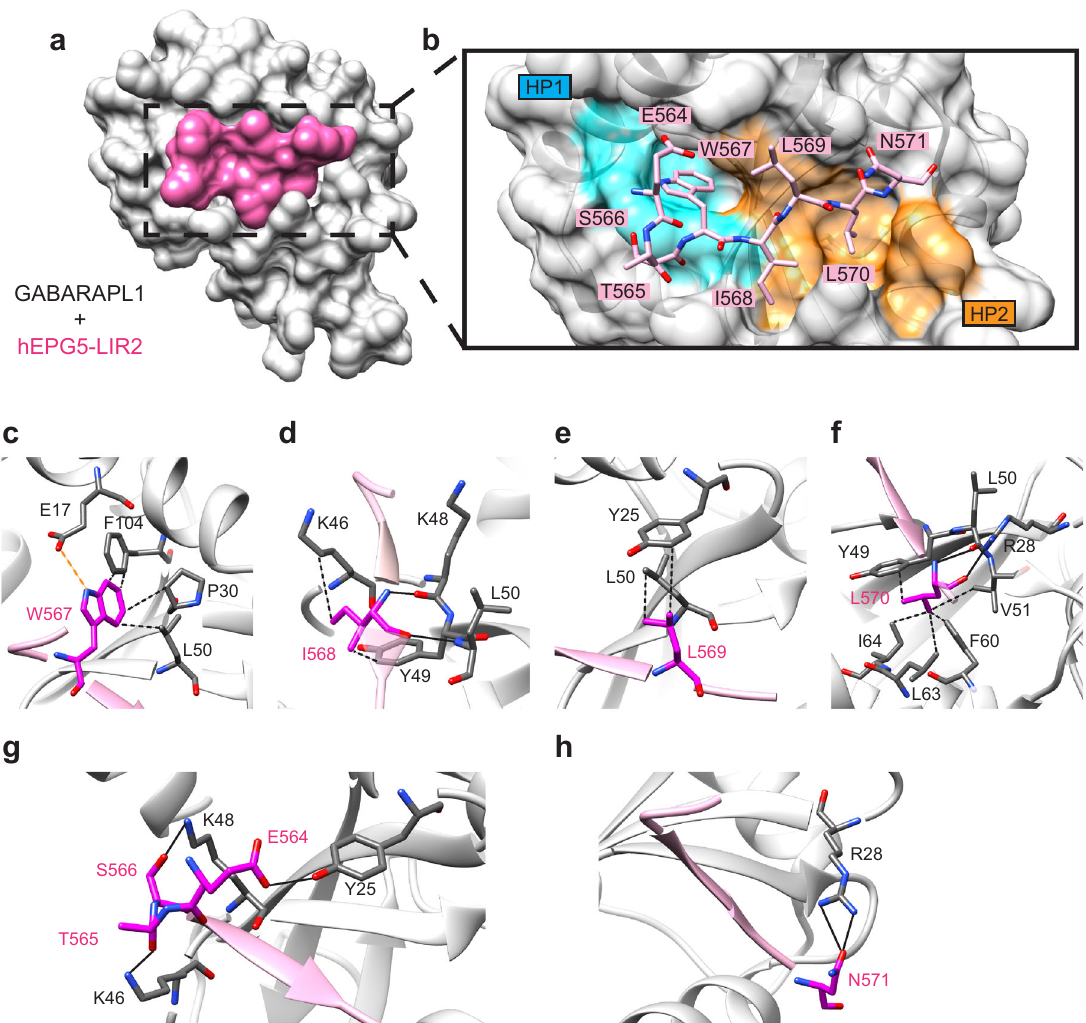
Fig. 4 Crystal structure of the LIR2 – GABARAPL1 complex. a Surface representation of complex between LIR2 peptide (magenta) and GABARAPL1 (gray) at 1.91 Å. b Close-up view of LIR2 peptide (sticks representation in pink) binding to canonical binding site on GABARAPL1 (ribbon and transparent surface representation in gray). Residues Trp567 and Leu570 of LIR2 inserted into hydrophobic pocket 1 (HP1 in cyan) and hydrophobic pocket 2 (HP2 in orange) through hydrophobic interaction, respectively. c – f Close-up view of the interactions between each of the LIR2 motif residues (magenta) and residues on GABARAPL1 (dim gray). Black and orange dotted lines represent hydrophobic and electrostatic interaction, respectively; black solid lines represent hydrogen bonds. c Side chain of Trp567 interacts with side chain of Pro30, Leu50, and Phe104 through hydrophobic interaction, as well as the carboxyl group on Glu17 side chain through electrostatic interaction. d Side chain of Ile568 interacts with side chain of Lys46 and Tyr49 through hydrophobic interaction; main chain of Ile568 forms hydrogen bonds with main chain of Lys48 and Leu50. e Side chain of Leu569 interacts with side chain of Tyr25 and Leu50 through hydrophobic interaction. f Side chain of Leu570 interacts with side chain of Tyr49, Val51, Phe60, Leu63, and Ile64 through hydrophobic interaction; main chain of Leu570 interacts with main chain of Leu50 and guanidinium group on Arg28 side chain. g , h Close-up view of the interactions between each of the LIR2 N- and C-terminal residues (magenta) and residues on GABARAPL1 (dim gray). Solid lines represent hydrogen bonds. g LIR2 N- terminal residues Glu564 side chain, Thr565 main chain, and Ser566 side chain form hydrogen bonds with side chain of Tyr25, Lys46, and Lys48, respectively. h LIR2 C-terminal residue Asn571 side chain form hydrogen bonds with guanidinium group on Arg28 side